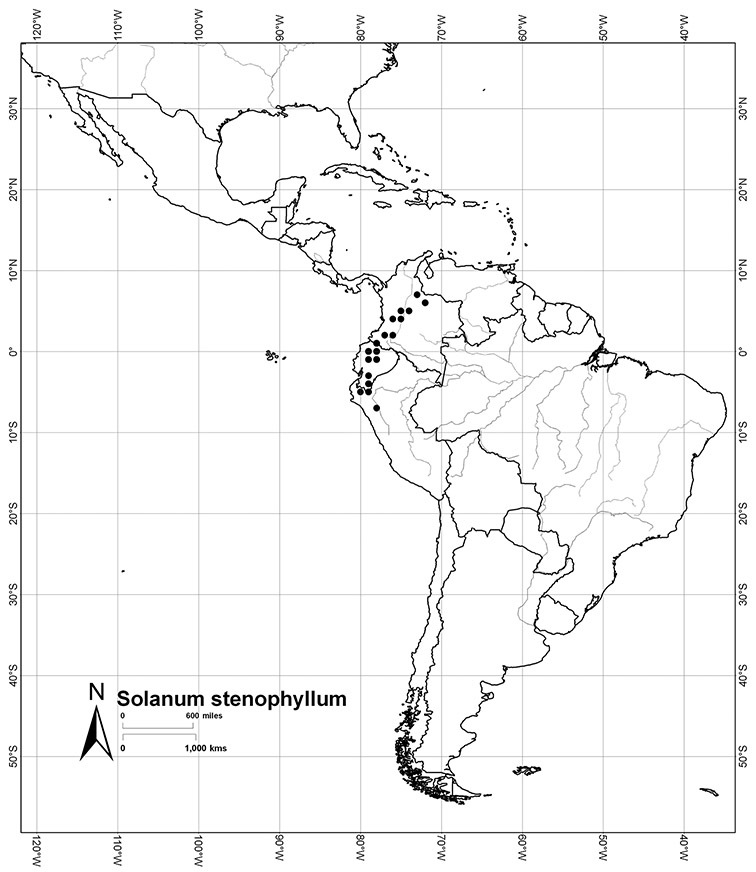
Distribution of Solanum stenophyllum Dunal.